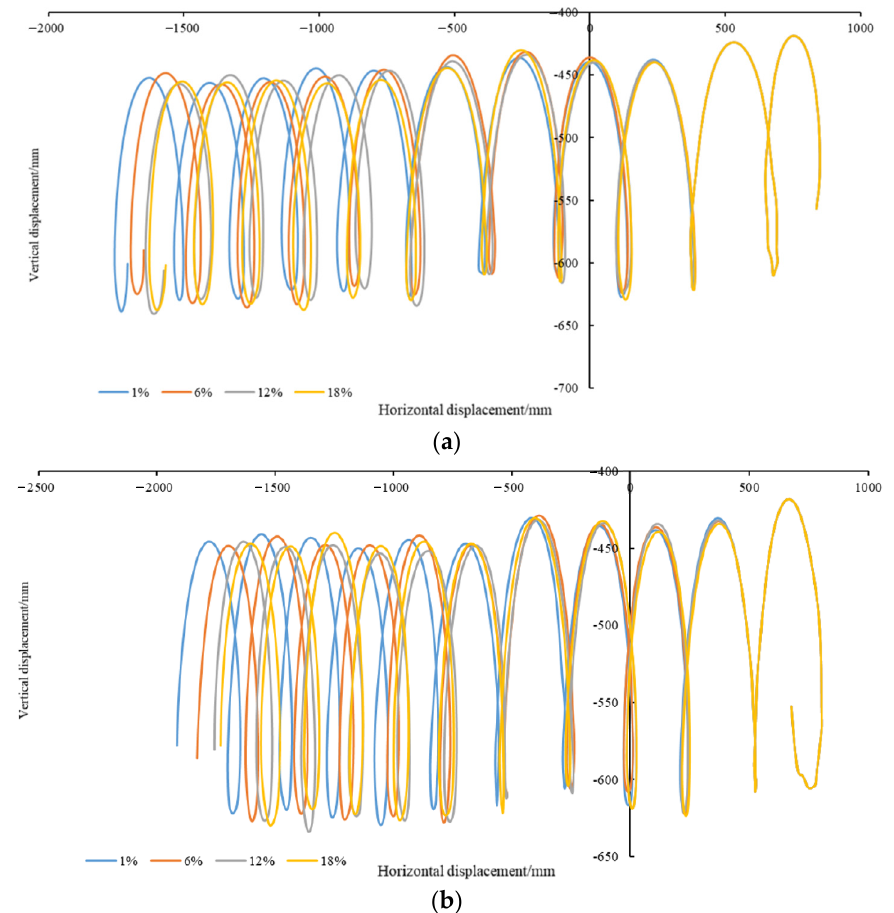
Figure 10. Trajectory of cavity seeders under sandy loam. ( a ) Right cavity seeder. ( b ) Left cavity seeder.